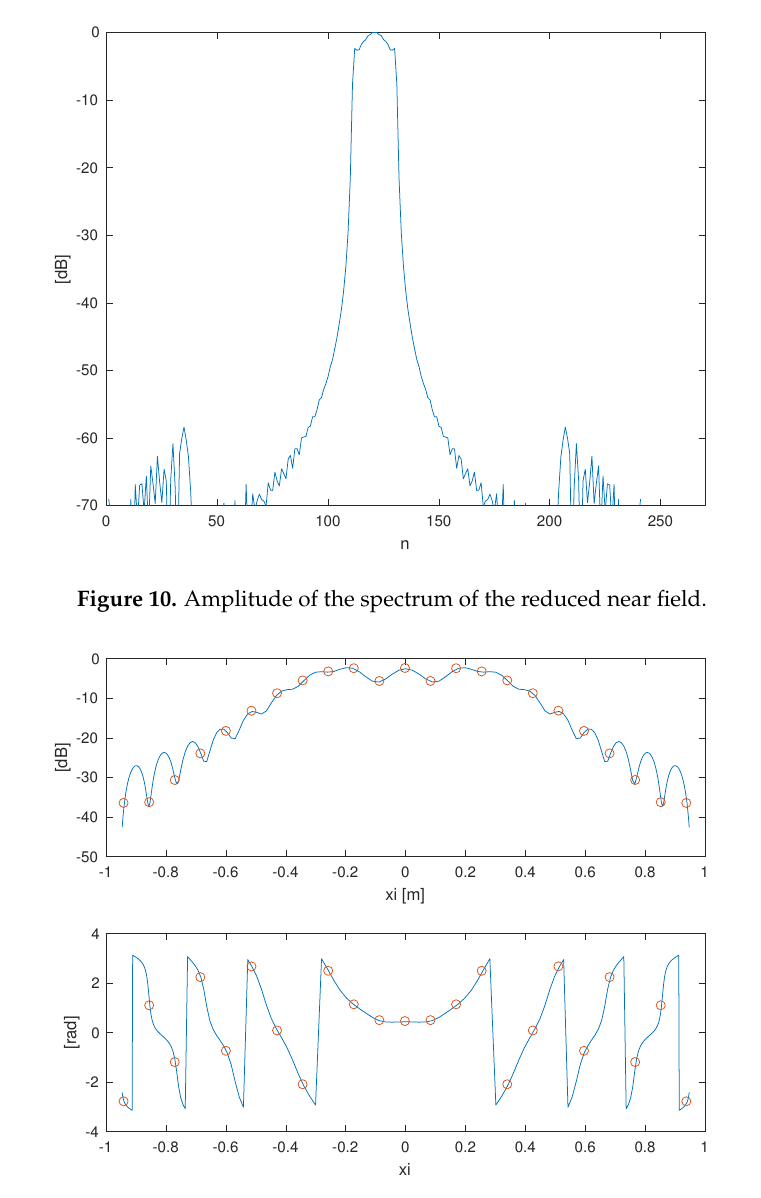
Figure 11. Reduced near field amplitude ( top ) and phase ( bottom ) along the observation line; the sampling points using the minimum redundant spatial sampling strategy are plotted as